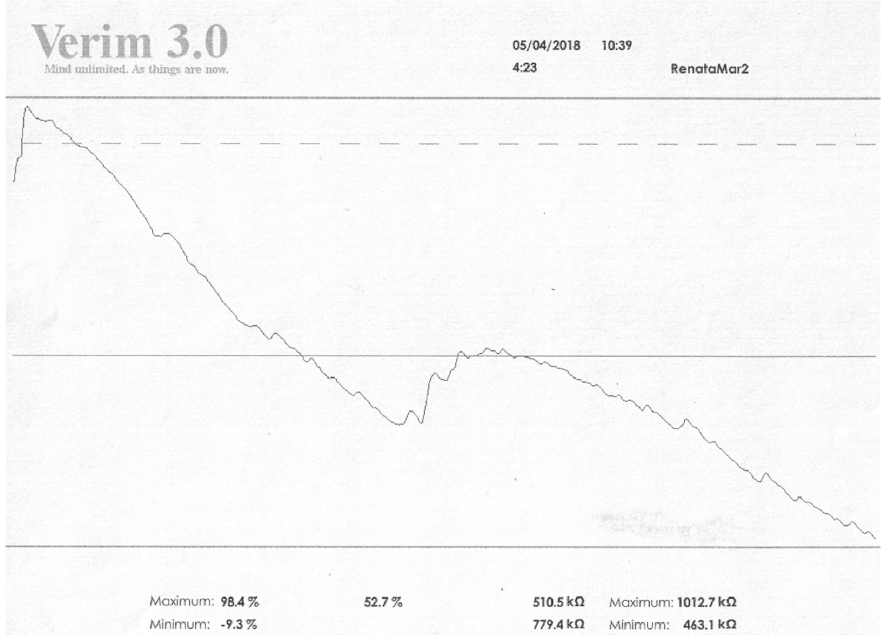
Figure 2. The results obtained in the field of EDA after 3 months of GSR Biofeedback therapy. Legend: max vs. min—values of resistance achieved by the patient in kOhm; values on the right refer to relaxation, on the left to activation. Higher values in relaxation training indicate an increase in resistance and thus an increase in relaxation; low values indicate a decrease in resistance, an increase in conductivity, and thus a decrease in relaxation. The values on the left side are the activation level. If relaxation increases, the activation of the organism decreases. Five max values vs. min are the results analogous to those presented in kOhm.